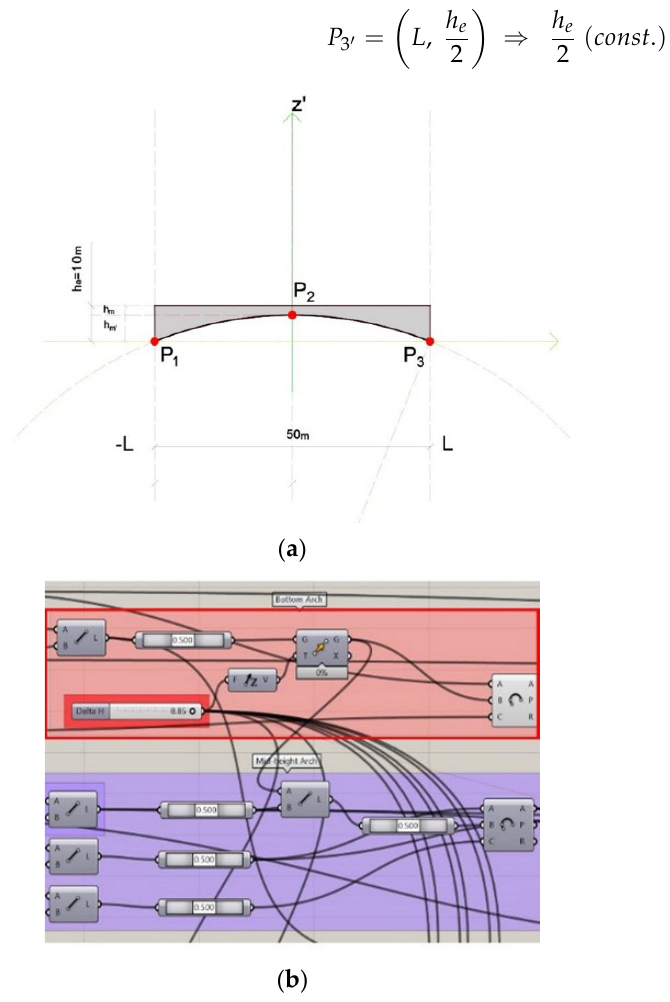
Figure 4. ( a ) Emptying function—the arc of circumference passing through three points; ( b ) Grasshopper development of the emptying function (upper definition in red).